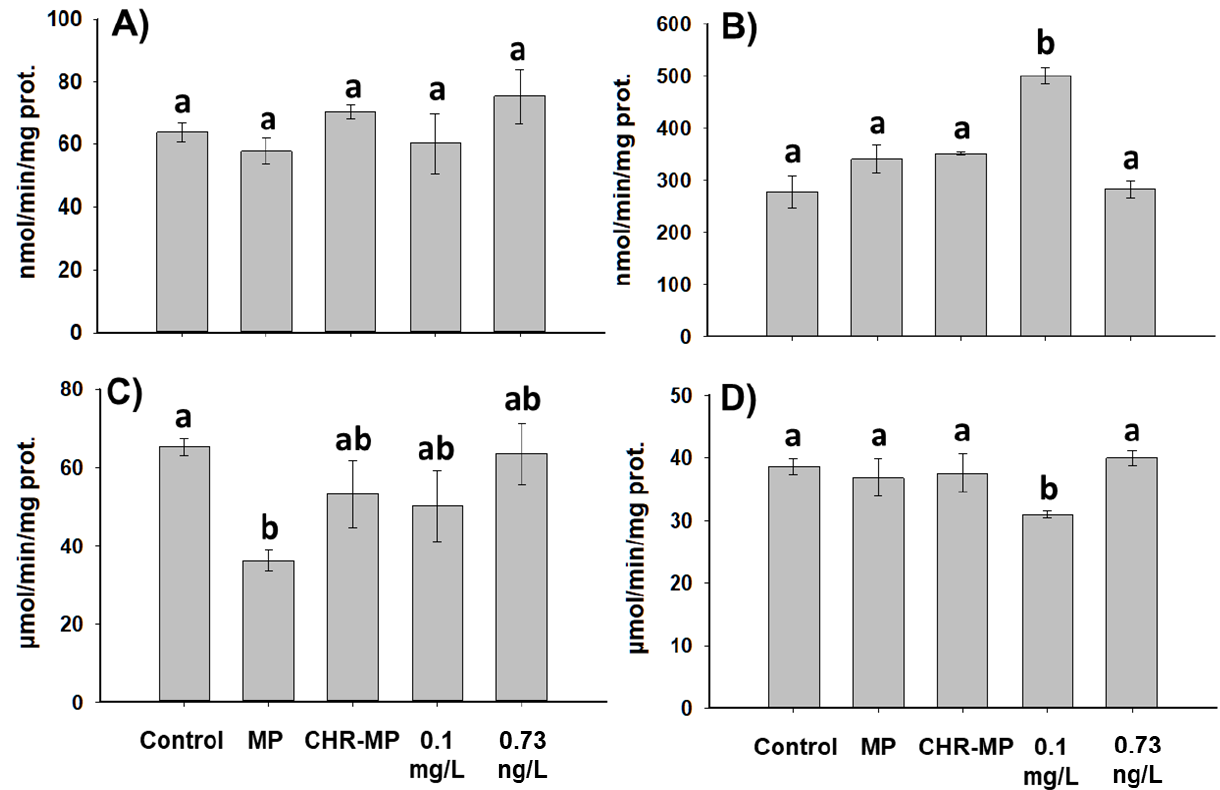
Figure 3. Specific activity of the enzymes GST and CAT (mean ± SEM, n = 3) measured in mussels after 7 days of exposure to 5 × 10 3 units/L of polystyrene microplastics (MP) and chrysene-loaded microplastics (CHR-MP), 0.1 mg/L and 0.73 ng/L of freely dissolved CHR (without MP); ( A , B ), GST activity in mussel digestive gland ( A ) and gills ( B ); ( C , D ), CAT activity in mussel digestive gland ( C ) and gills ( D ). Different letters denote statistically significant differences ( p < 0.05, ANOVA—Bonferroni post-hoc comparison) among treatments.